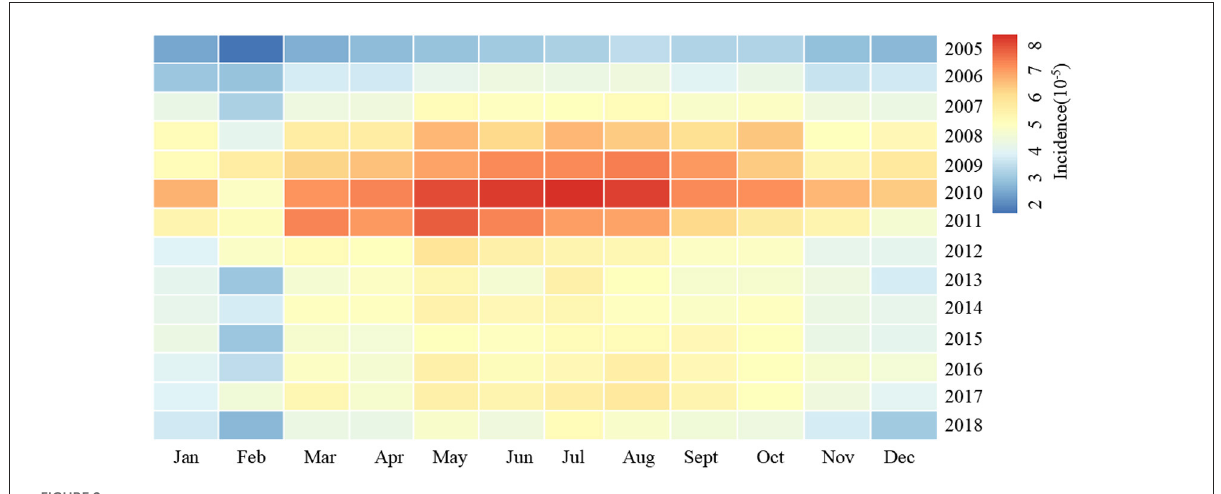
FIGURE2 Temporal distribution of syphilis monthly incidence in Zhejiang Province,